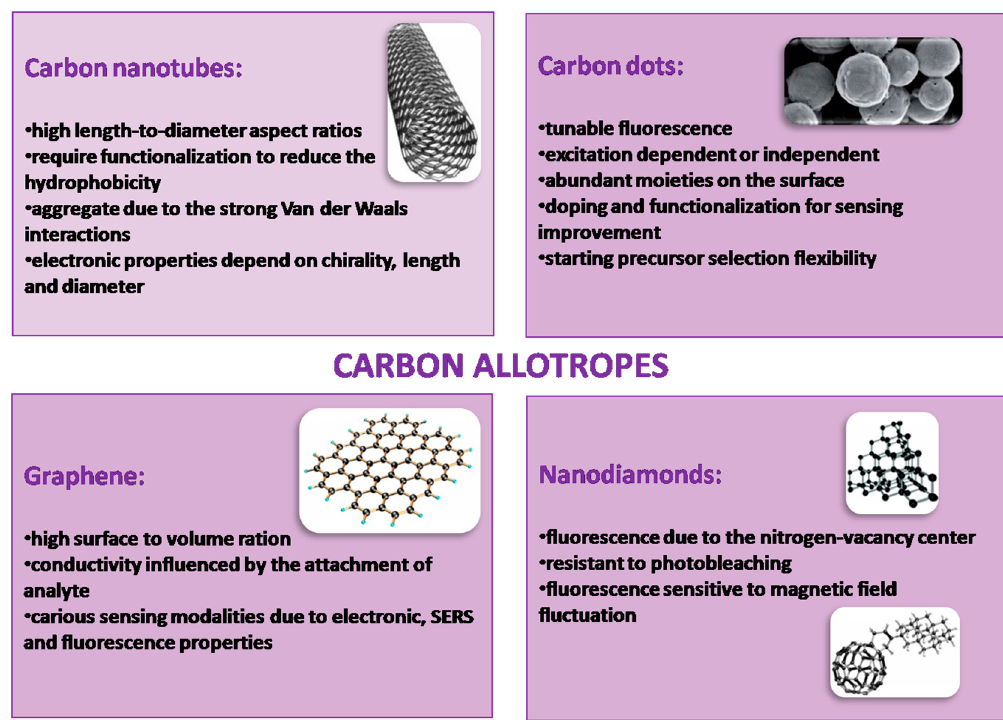
Figure 3. Various carbon allotropes’ properties.